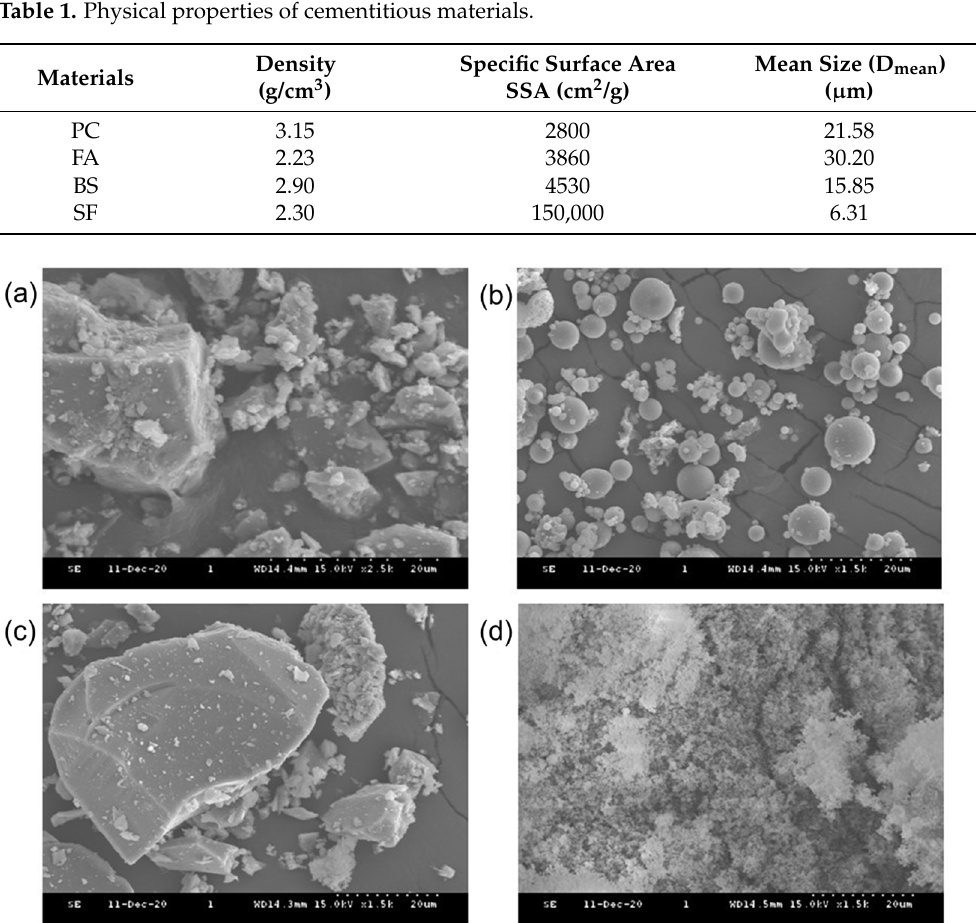
Figure 2. Particle-size distributions (PSDs) of cementitious materials. 3.2. Mixture Formulations and Procedures Four groups of non-blended mixtures were prepared using PC, FA, BS, and SF ma- terials with different water-to-solid volume ratios. The water-to-solid volume ratios were quantified as the volumetric ratios, as the rheological properties generally governed by volume ratio rather than weight ratio. All the mixtures were proportioned with different water-to-solid volume ratios (w/s) v varied from 1.25, 1.50, 1.75, 2.00, 2.25, to 2.50, which